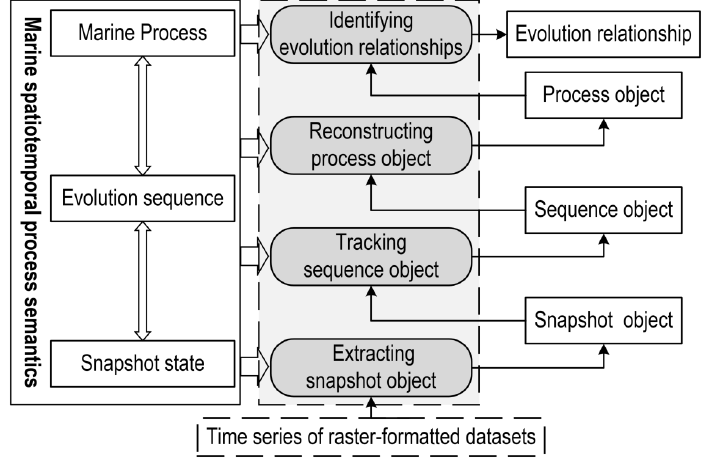
Figure 5. Workflow of process-oriented extraction module.